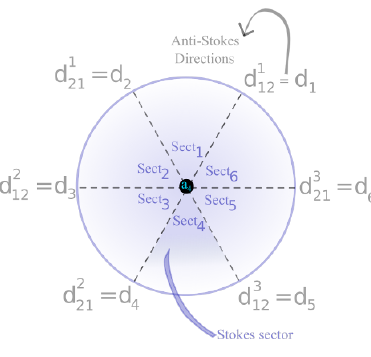
Figure 4 . Anti-Stokes